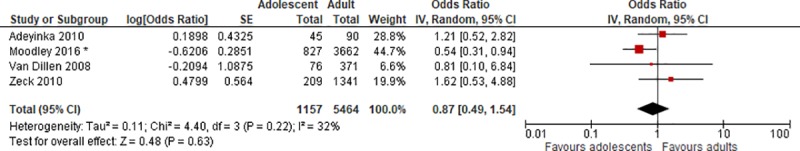
Forest plot for stillbirth.* Adjusted OR. IV, inverse variance; CI, confidence interval.